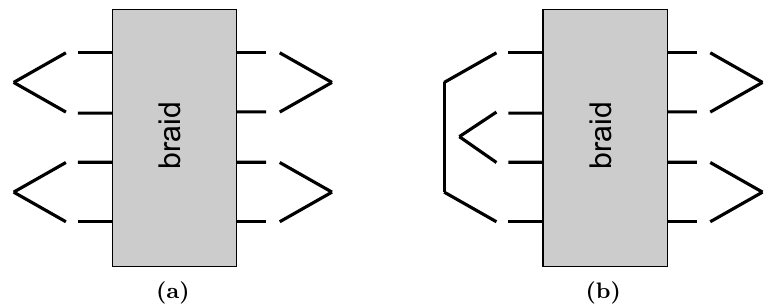
Figure 11. Braid word presentation of the 2-bridge knot L n;m . On the right end, we always close by neighboring pairs (as in (4.9)). On the left end, the closure prescription depends on what is the leftmost braiding operation in the word: if it is given by (cid:27) 2 , which acts on the second and